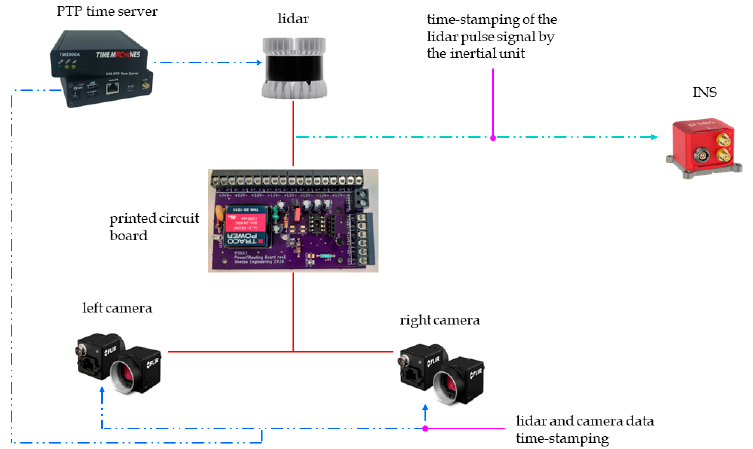
Figure 4. Data synchronization and time-stamping scheme.